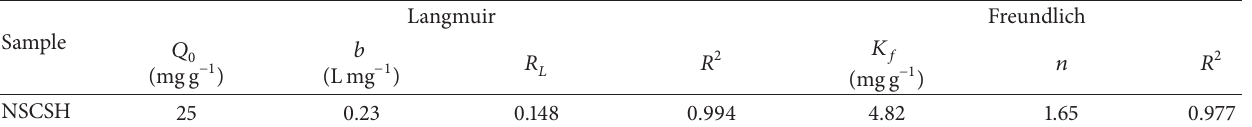
Table 5: Isotherm parameters for RhB adsorption onto NSCSH.